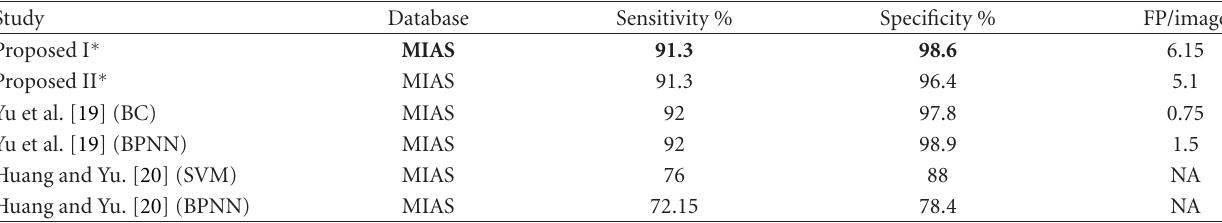
Table 2: Comparison with related